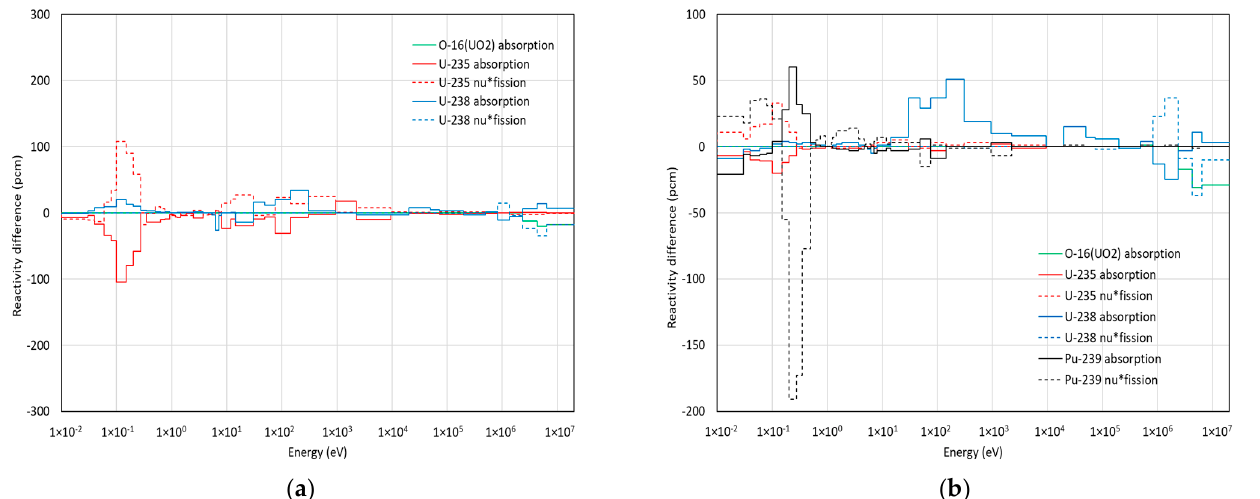
Figure 9. Reaction-dependent groupwise reactivity differences caused by the reaction rate differences for the typical PWR fuel pin: ( a ) zero burnup; ( b ) 60 MWD/kgU burnup.